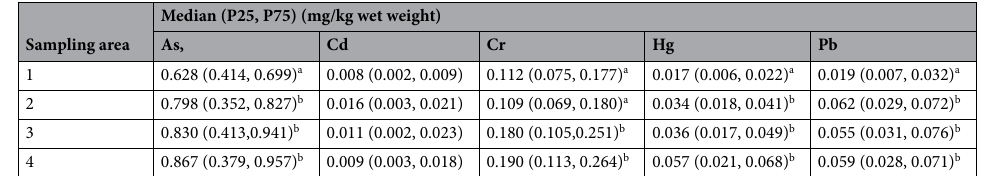
Table 4. Comparison of different heavy metals in marine fish from four sample areas in Zhejiang, China. Means followed by different letters (a and b) in each column are significantly different ( P < 0.05).